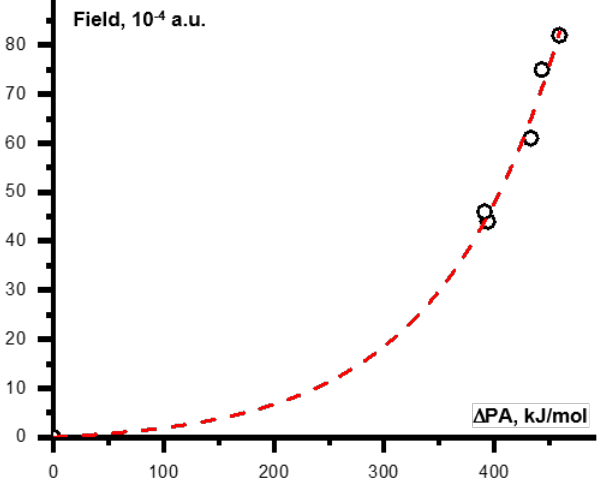
Figure 7. A functional dependence between the lower limit of the external electric field at which the energy minima of the Acid-H···Base and Acid − ···[H-Base] + forms of an H-bonded complex in the CDF 3 /CDClF 2 are equal and the difference between the PAs of a proton donor and an acceptor, ∆𝑃𝐴 . Proton tautomerism acceptor···H-donor ⇌ [acceptor-H] + ···(donor) - in CDF 3 /CDClF 2 is strongly